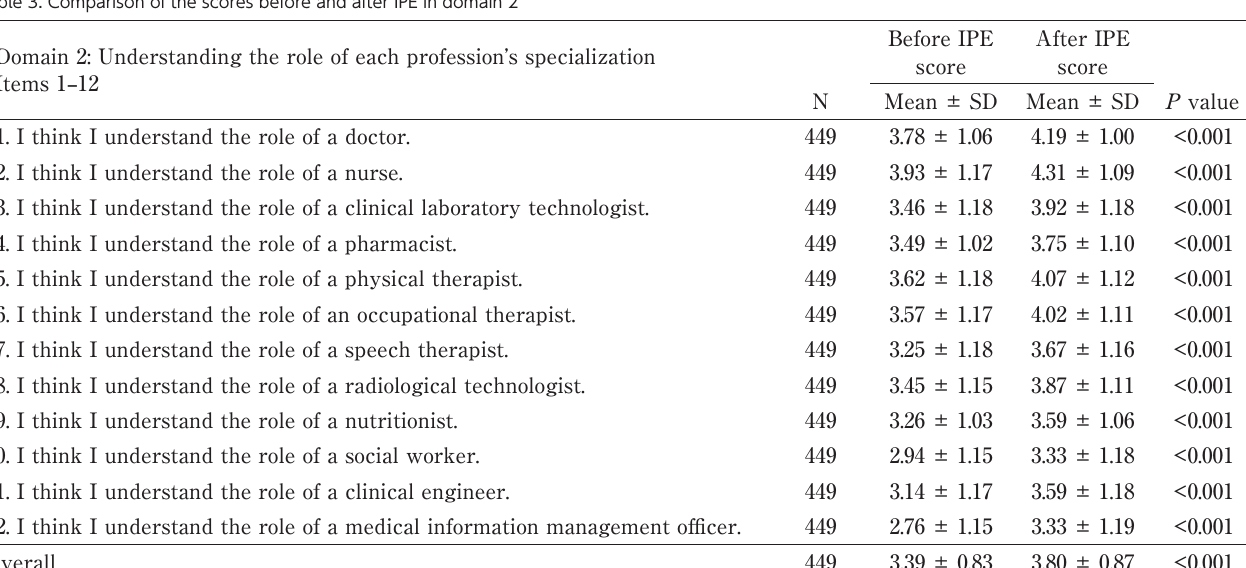
Table 3. Comparison of the scores before and after IPE in domain